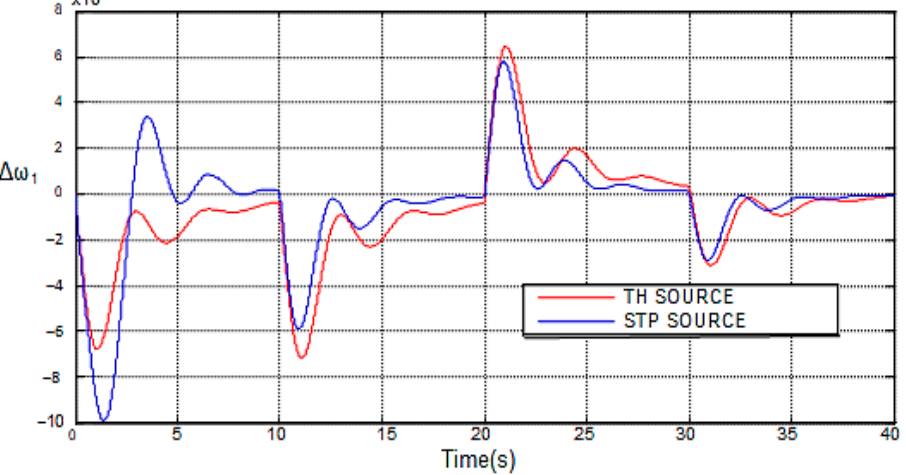
Figure 14. Frequency variations of area 1 without and with STP and variable SLP.